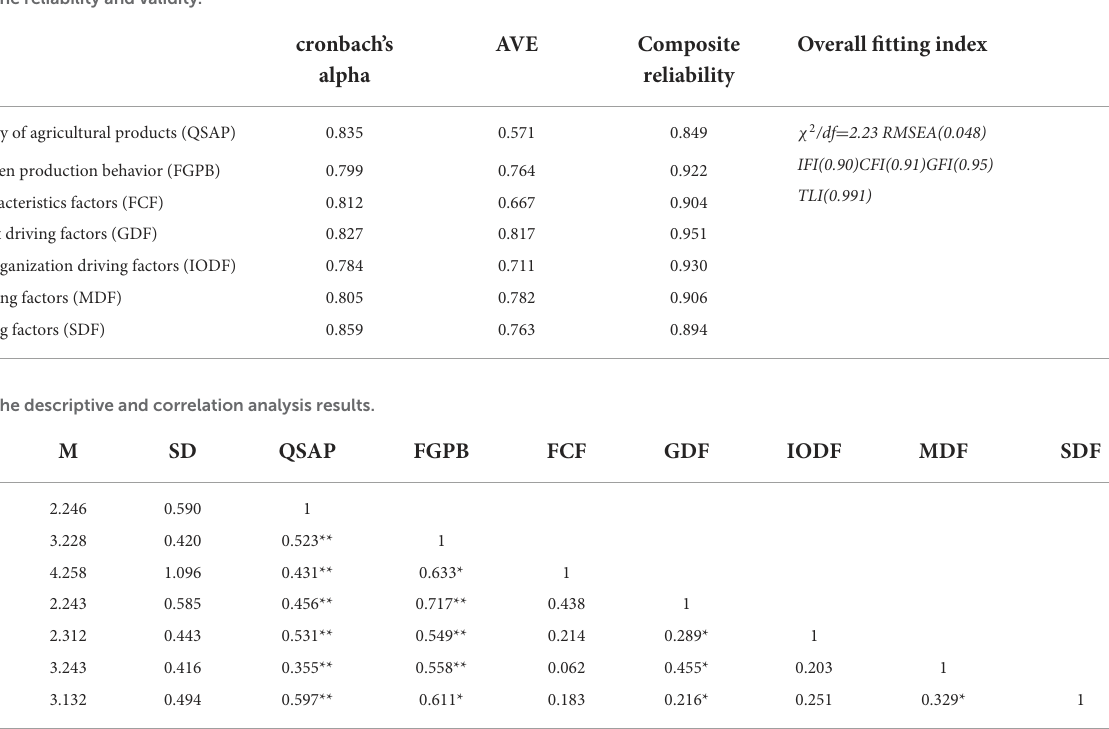
TABLE 3 The reliability and validity.